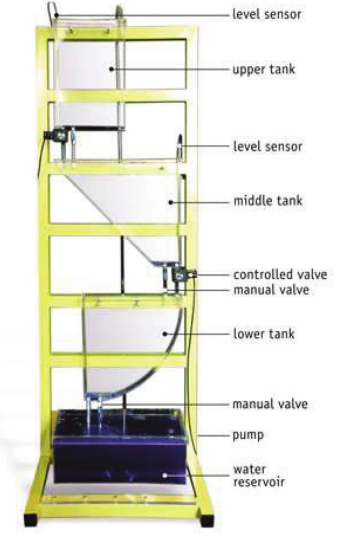
Fig. 4. Model of the multi tank